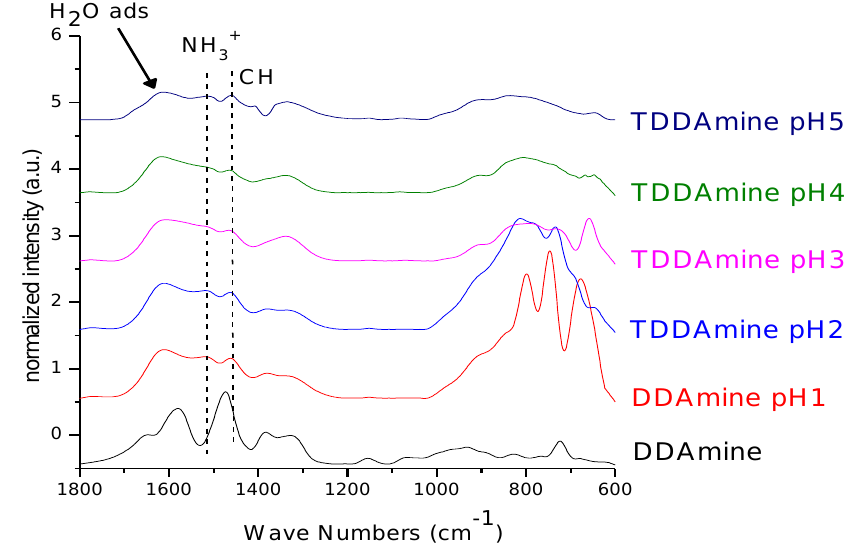
at pH 1, 2, 3, 4, and 5. 2